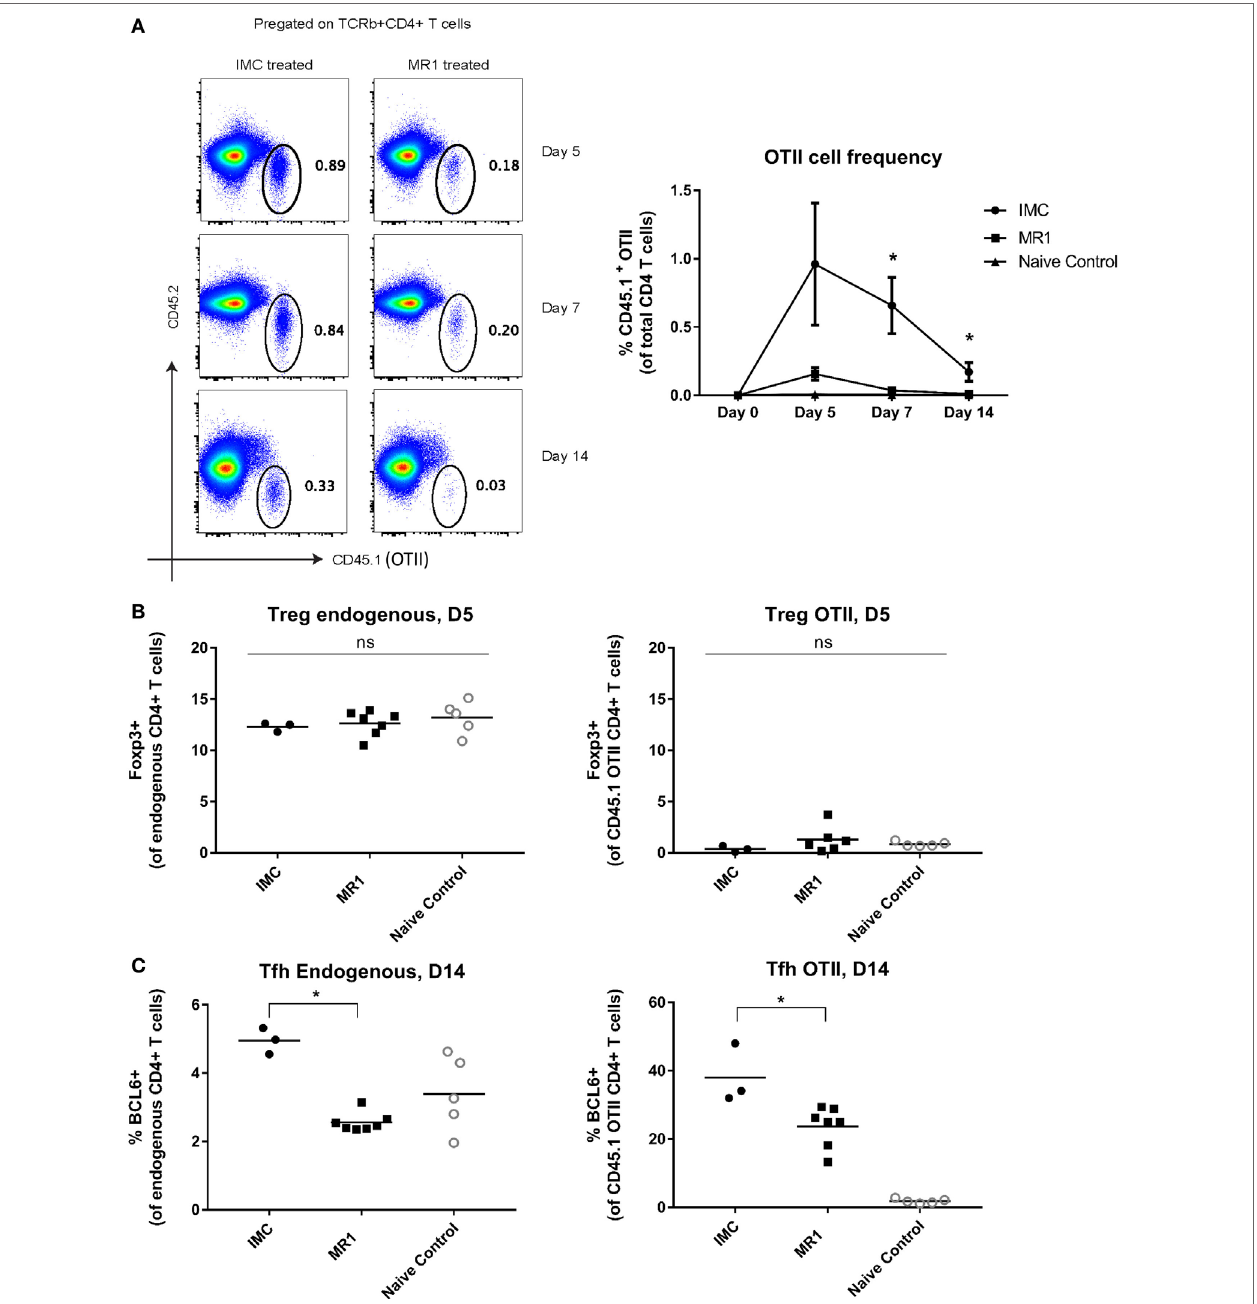
FigUre 4 | CD40/CD40L blockade prevents expansion of antigen-specific CD4 + T-cells. (a) Representative flow plots showing gating strategy for OTII cells gated as CD45.1 + CD4 + T-cells, and frequency of OTII cells at days 0, 5, 7, and 14 post-transfusion in mice treated with or without MR1. (B) Endogenous and OTII regulatory T-cells (Tregs) (Foxp3 + CD4 + T-cells). (c) Endogenous and OTII TFH (BCL6 + ). * p < 0.05 determined by Mann–Whitney U test or ANOVA. Data are representative of at least two experiments ( n = 3–6 mice per group per